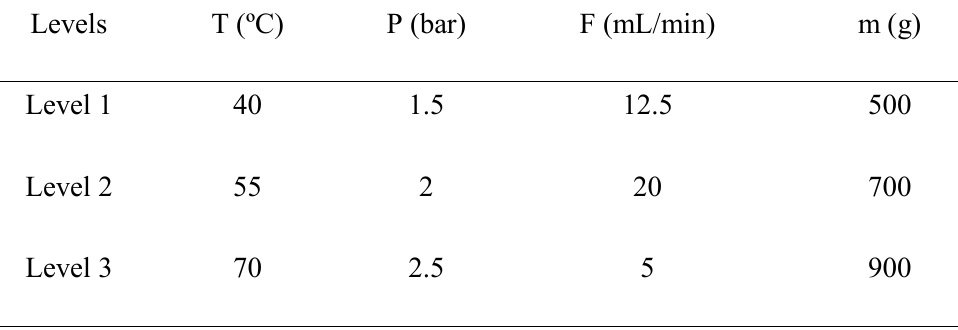
Factors and their levels for fluidized bed granulation study of Lactose Particles using Taguchi